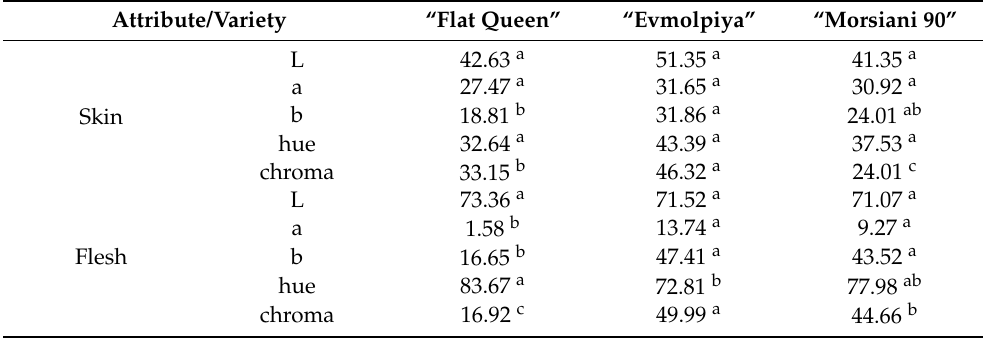
Table 3. CIELAB skin and flesh color measurements of late ripening peach ( Prunus persica L.) varieties.